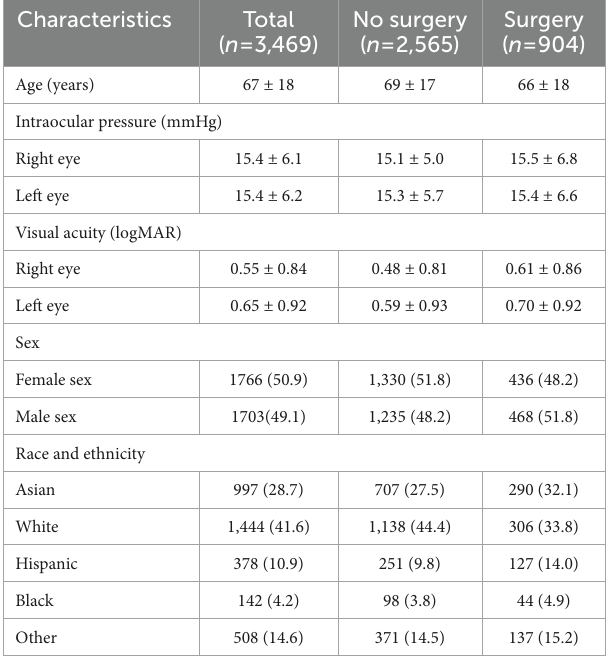
TABLE 2 Population